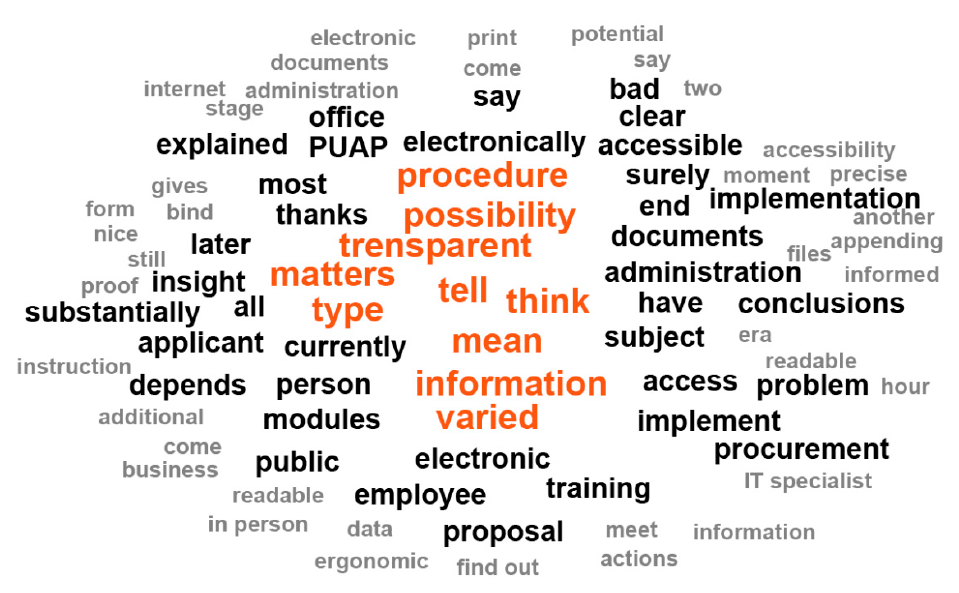
Figure 2. Word cloud: transparency.